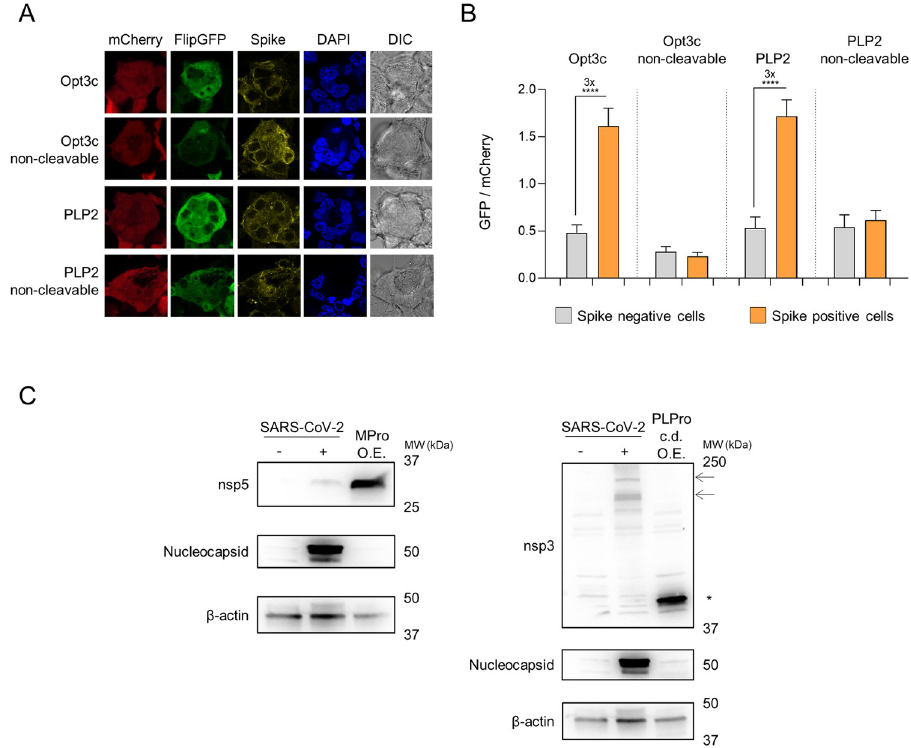
Fig 2. Activation of FlipGFP-based reporters by SARS-CoV-2 infection. ( A-B ) HEK293T-ACE2 cells were transfected with indicated FlipGFP biosensors, incubated for 12 h, then infected with SARS-CoV-2 at MOI = 1. Cells were fixed, permeabilised and stained for SARS-CoV-2 spike protein 24 h post-infection. FlipGFP and mCherry fluorescence in spike+ syncytia vs. spike- cells were analysed by confocal microscopy. Illustrative microscopy data from spike+ syncytia ( A ) and mean values ± SEM for at least 15 syncytia/cells from each condition ( B ) are shown, representative of 2 independent experiments. ���� p < 0.0001. mCherry, red. FlipGFP, green. Spike, yellow. DAPI, blue. DIC, differential interference contrast. ( C ) Expression levels of SARS-CoV-2 proteases. HEK293T-ACE2 cells were mock-infected, infected with SARS-CoV-2 at MOI = 1 or transfected with MPro (left panel) or PLPro (right panel) under standard conditions. Cells were lysed after 24 h and analysed by immunoblot using antibodies specific for nsp5 (MPro), the PLPro c.d. of nsp3 or nucleocapsid. β -actin was included as a loading control. Arrows indicate presumed full-length nsp3 (215 kDa) and intermediate cleavage products present in SARS-CoV-2-infected cells. Asterisk indicates recombinant PLPro c.d.. Representative of 2 independent experiments. O.E., over-expression. MPro, recombinant SARS-CoV-2 Main Protease. PLPro c.d., catalytic domain of recombinant SARS-CoV-2 Papain-Like